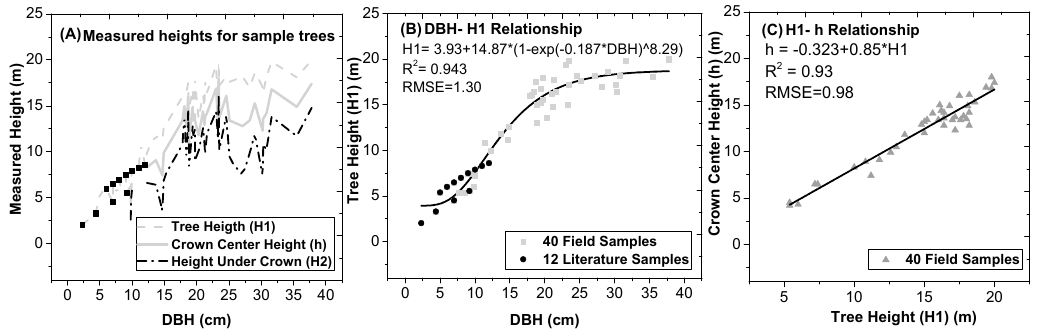
Figure A3. ( A ) Measured height values for 40 sample trees with increasing DBH. The measured data include tree height ( H1 ), height of crown center ( h ) and height under crown ( H2 ); Regression relationships between DBH and tree height ( B ) and between tree height and crown center height ( C ).